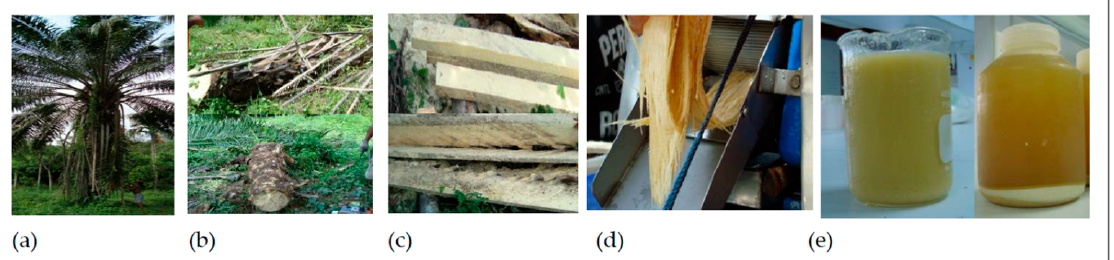
Figure 1. Oil palm tree ( a ), shedding and logging ( b ), slicing to disks ( c ), squeezing ( d ), and oil palm squeezed sap (OPT sap) ( e ).